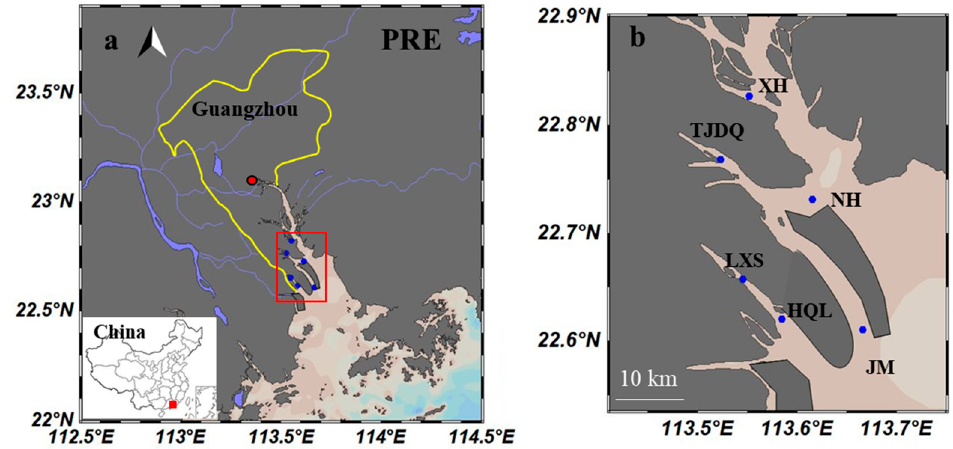
Figure 1. Locations of sampling sites (blue points) on the Pearl River Estuary ( a ) and Nansha, South Guangzhou ( b ) maps (created by Ocean data view).